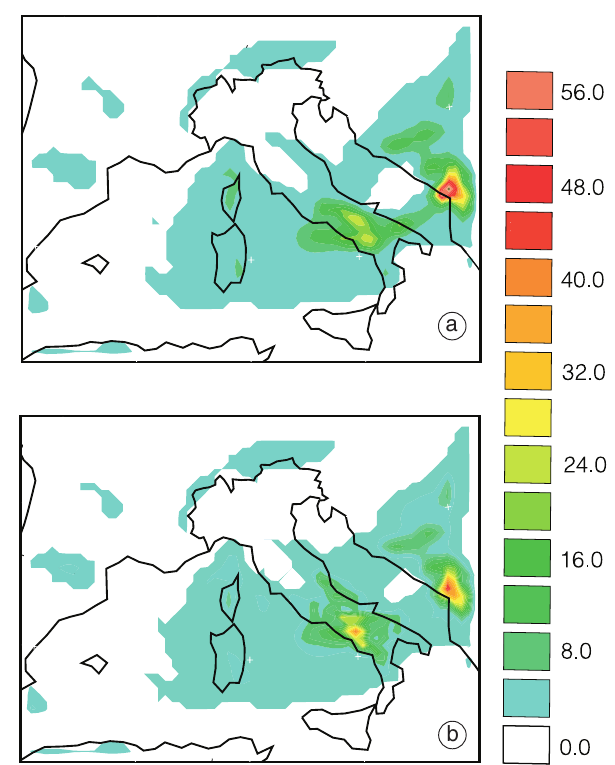
Fig. 4a,b. 24 h accumulated precipitation (mm) at ending at 0000UTC 5th May predicted on domain 1 by using: a) one domain at 27 km grid